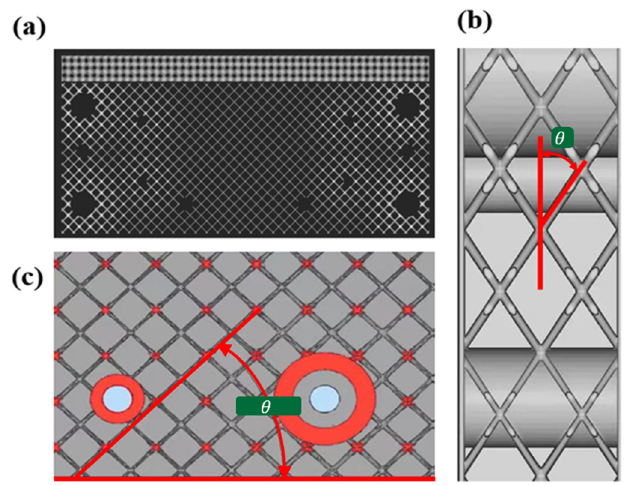
Figure 1. Satellite cabin structure with lattice cells: ( a ) various cell configurations; and ( b , c ) cell inclination angle in the printing direction.